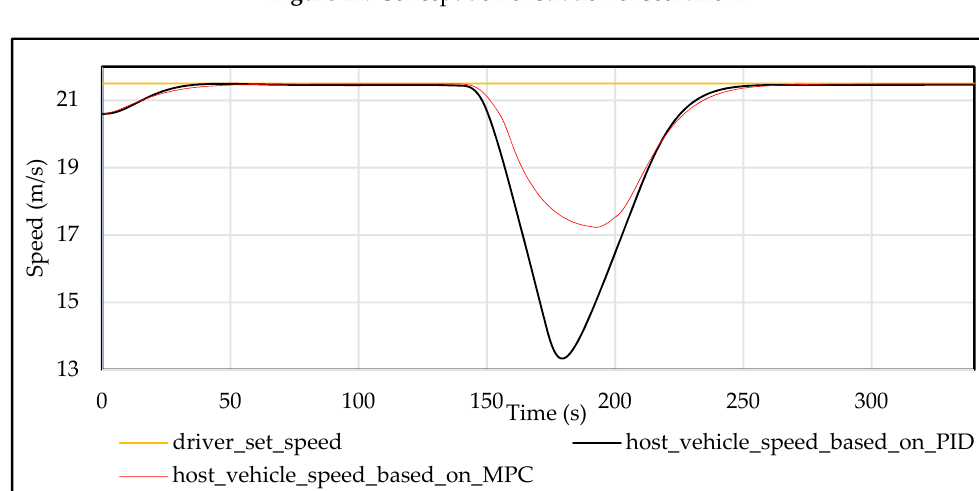
131517 Figure 12. Speed response in scenario 2 . Figure 13. Acceleration response in scenario 2 . Figure 13. Acceleration response in scenario 2 .